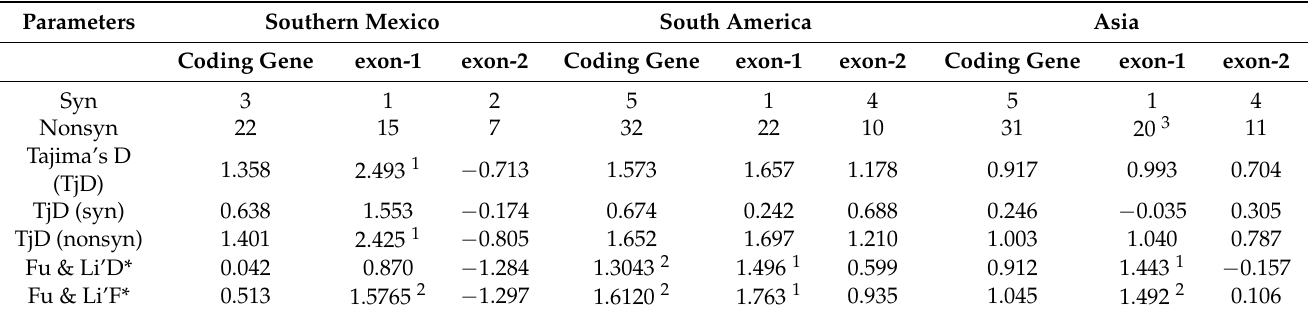
Table 4. Neutrality tests for the P. vivax cyrpa coding sequence; entire sequence and by exon. Parameters Southern Mexico South America Asia Coding Gene